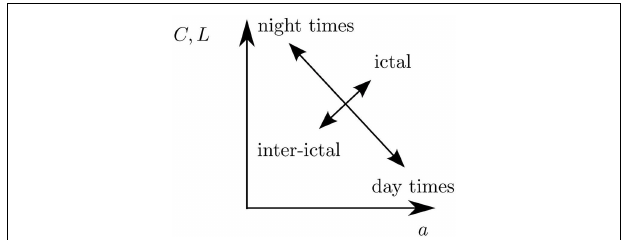
FIGURE 6 | Sketch of how functional brain networks may explore the space of accessible network topologies (here parametrized by the clustering coefficient C , average shortest path length L , and assortativity coefficient a ) in a process-dependent way: Daily rhythms may be reflected in periodic reorganizations of functional brain networks. Superimposed on that may be a reorganization in functional network connectivity reflecting pathophysiological